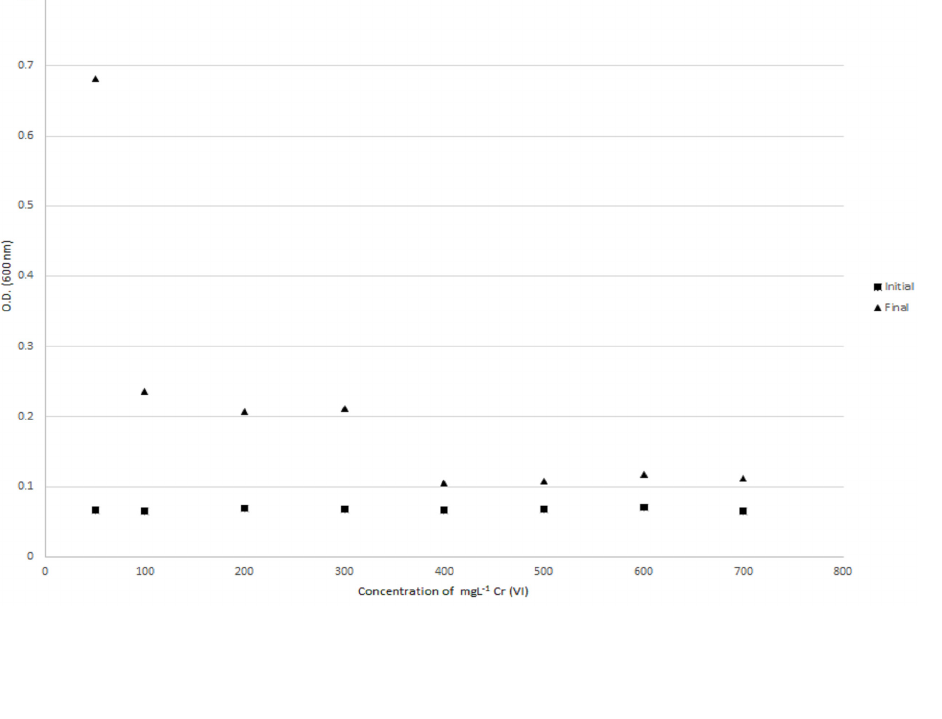
Figure 2. Kinetic cellular growth of the strain